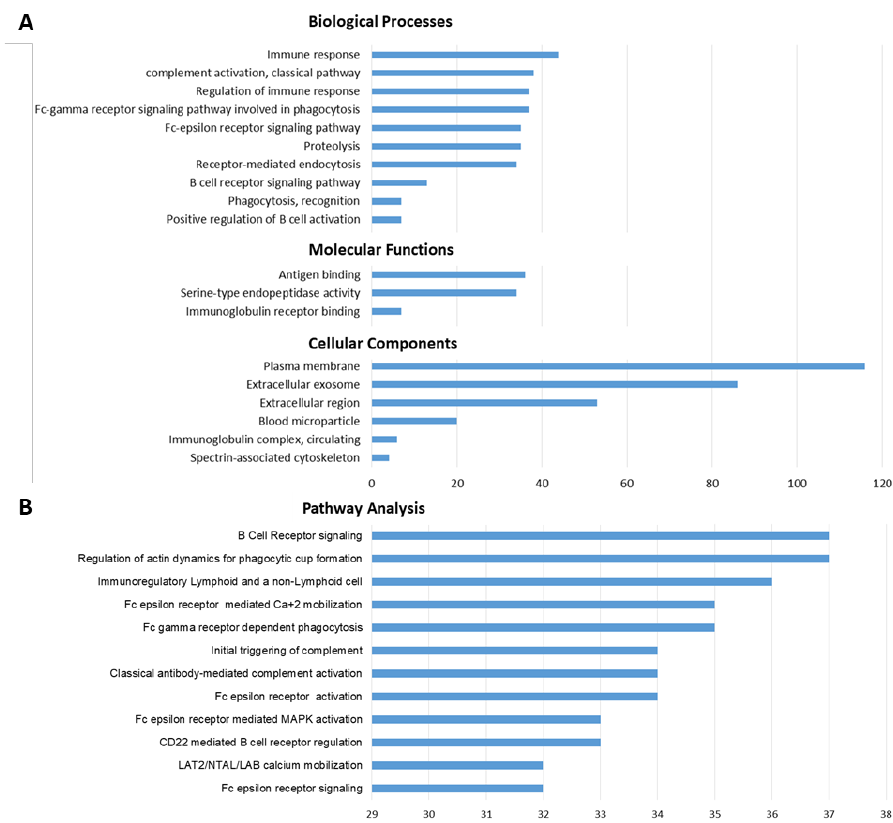
Figure 5. The histograms illustrate the category of enriched GO terms ( A ) and enriched pathways ( B ) for the DE genes. The horizontal axis represents the number of genes.